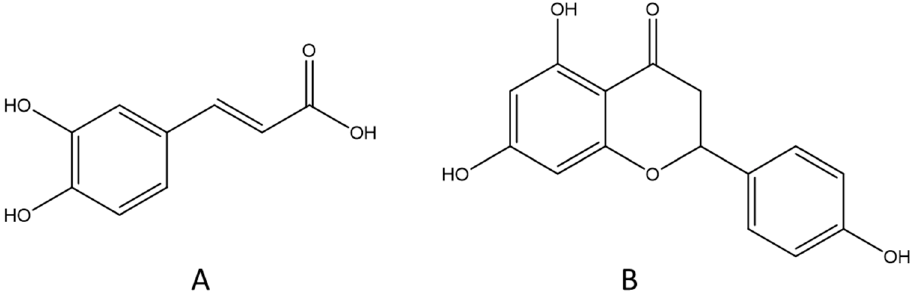
Figure 3. The structures of caffeic acid ( A ) and naringenin ( B